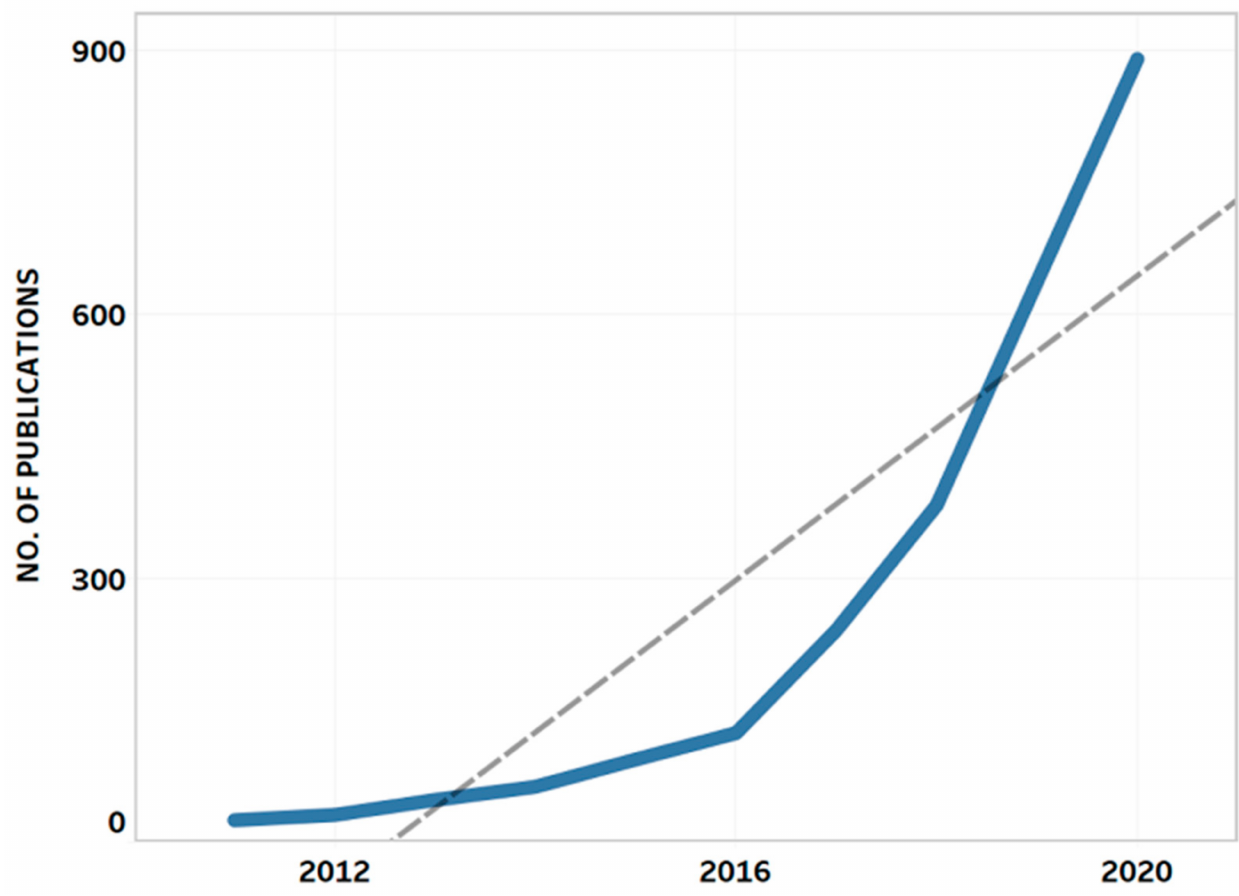
Figure 1. Annual growth of publications on antimicrobial resistance. The dashed line represents the trend line showing a positive trend in AMR-related